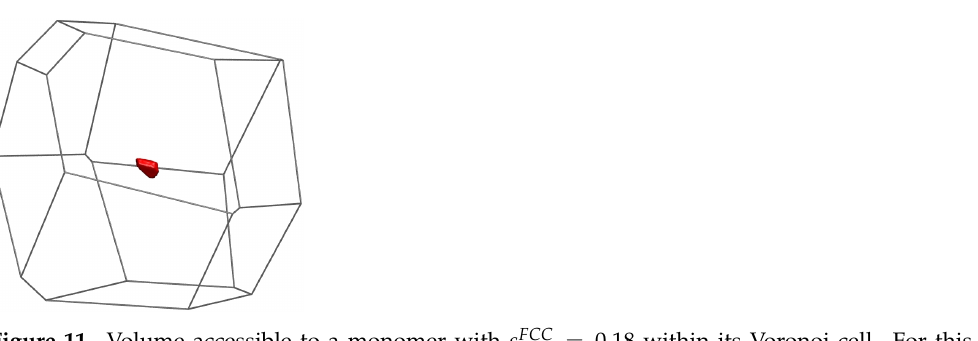
Figure 11. Volume accessible to a monomer with ε FCC = 0.18 within its Voronoi cell. For this monomer: V ac / V VC = 0.00024. Accessible volume is colored in red and the Voronoi polyhedron is shown in wireframe representation.